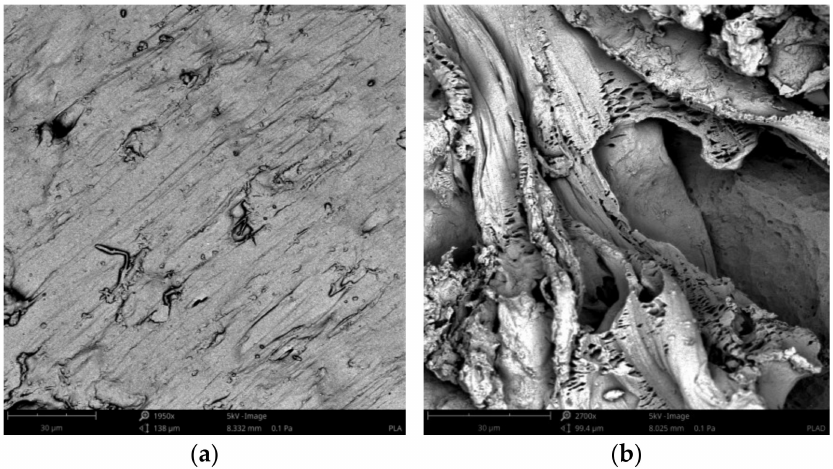
Figure 10. SEM images of sample P before the treatment by proteinase K ( a ) and sample P after the treatment by proteinase K ( b ).